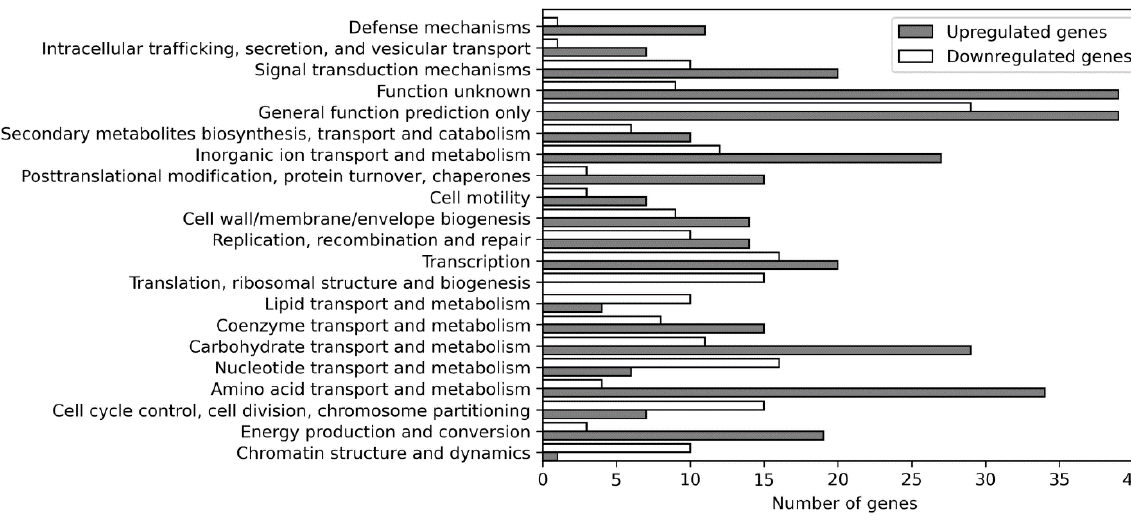
Figure 7. Functional annotation of proteins of DEGs by the cluster of orthologous groups.